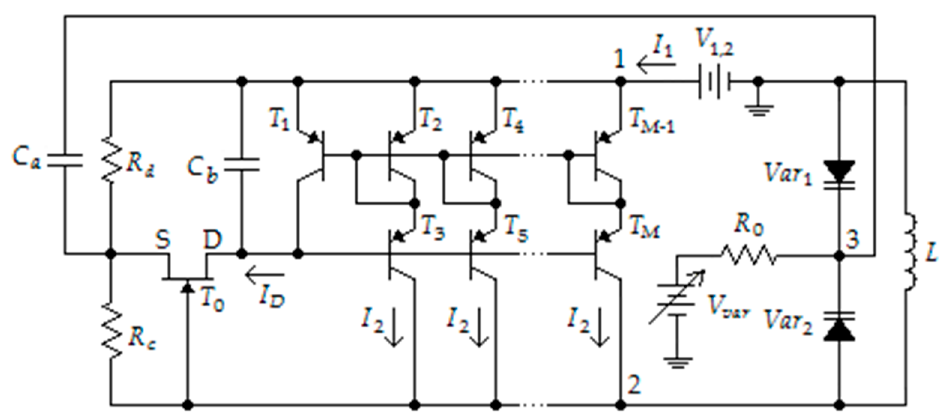
Figure 9. Voltage-controlled oscillator with multiple-output cascode current mirror.